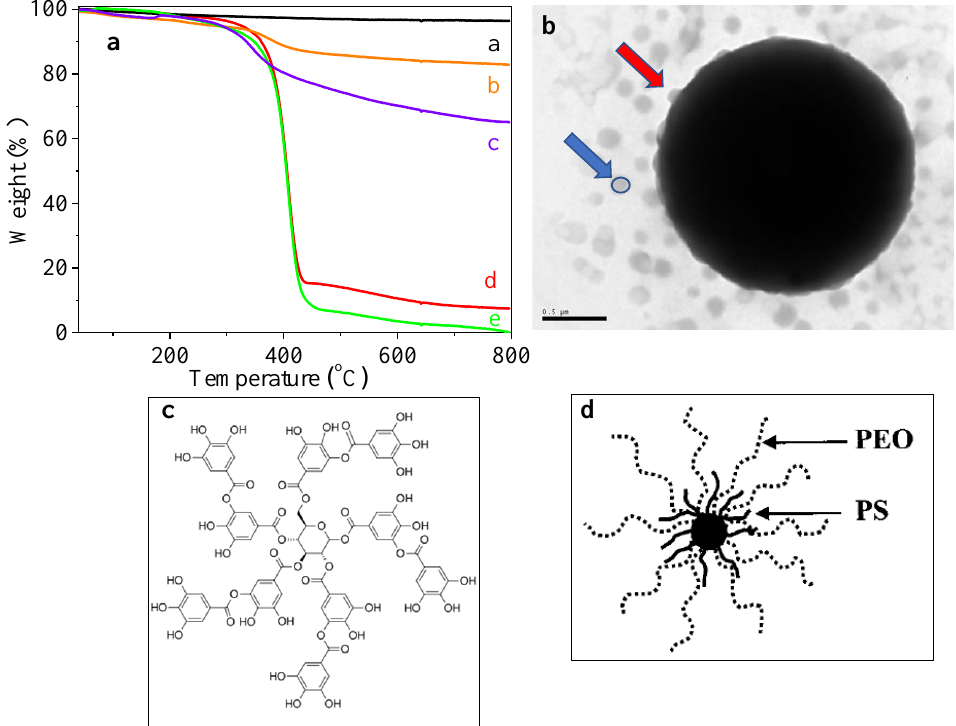
Figure 4. ( a ) TGA curves of (a) the bare SiO 2 (black line), (b) SiO 2 @P2VP- b -PEO (orange line), (c) SiO 2 @P2VP- b -PEO@tannic acid (TA)@ polystyrene–poly(ethylene oxide) (PS 10 -PEO 10 ) (purple line), (d) P2VP- b -PEO (red line), and (e) PS 10 -PEO 10 (green line); ( b ) TEM image of an SiO 2 @P2VP- b - PEO@TA@PS 10 -PEO 10 particle, scale bar: 500 nm; the blue and red arrows indicate the free and adsorbed PS 10 -PEO 10 micelles, respectively. ( c ) Molecule of tannic acid; ( d ) a monomolecular micelle of the star-shaped PS 10 -PEO 10 copolymer.